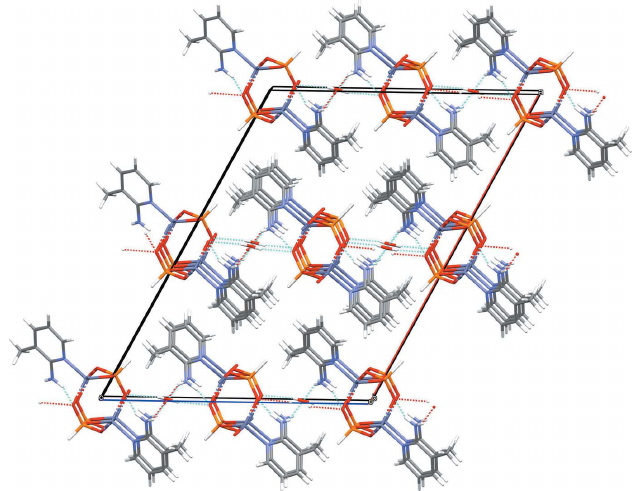
Figure 8 The unit-cell packing in (I) viewed down [001]. Hydrogen bonds are shown as dashed